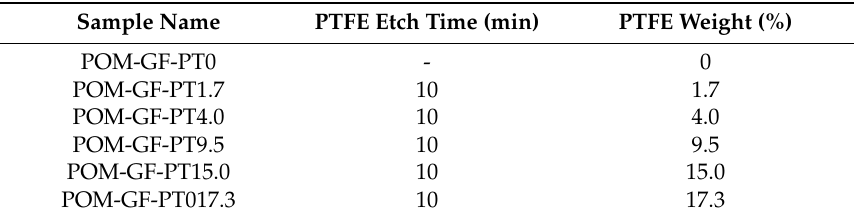
Table 1. The composition of POM/GF/PTFE composites